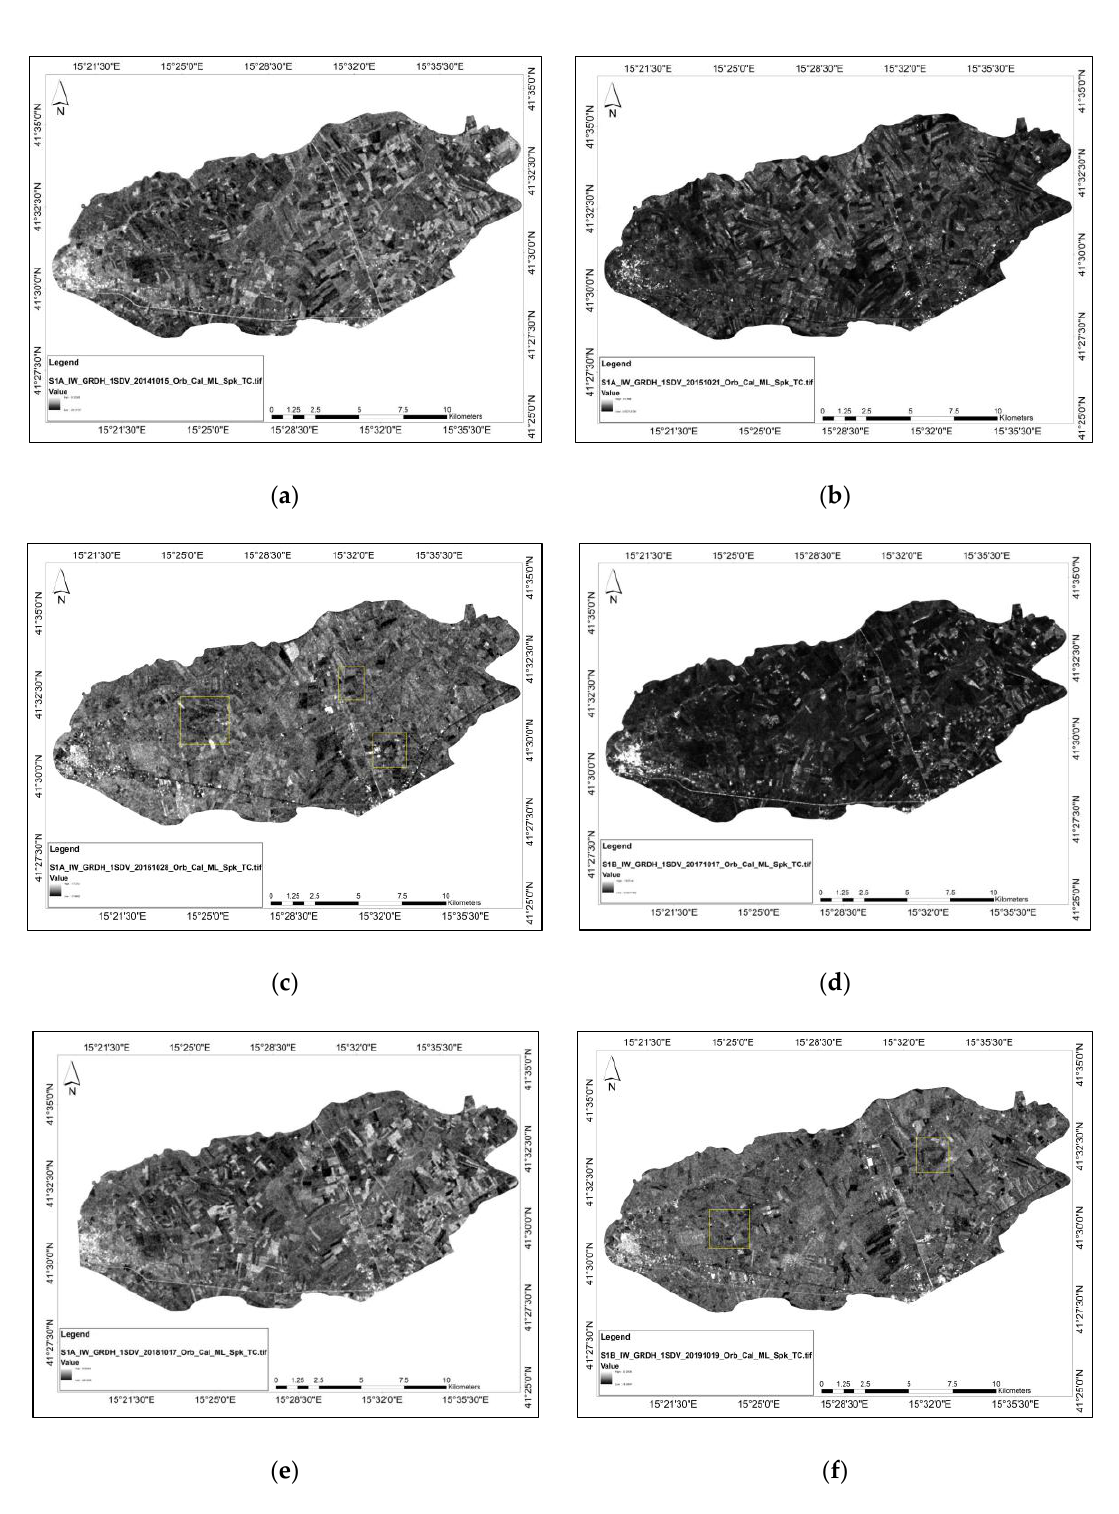
Figure 5. The analysed SAR data in October 2014, 2015, 2016, 2017, 2018, and 2019: ( a ) S-1 captured on 15 October, 2014; ( b ) S-1 captured on 21 October, 2015; ( c ) S-1 captured on 26 October, 2016; ( d ) S- 1 captured on 17 October, 2017; ( e ) S-1 captured on 17 October, 2018; ( f ) S-l1 captured on 19 October 2019. Yellow boxes are expected archaeological